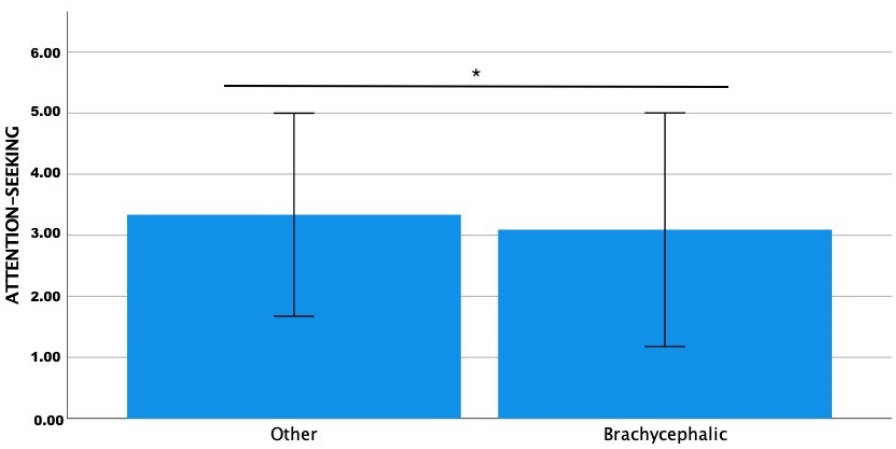
Figure 5. Comparison of Fe-BARQ mean scores for affection-/attention-seeking between brachyce- phalic and non-brachycephalic breeds. * p = 0.002.